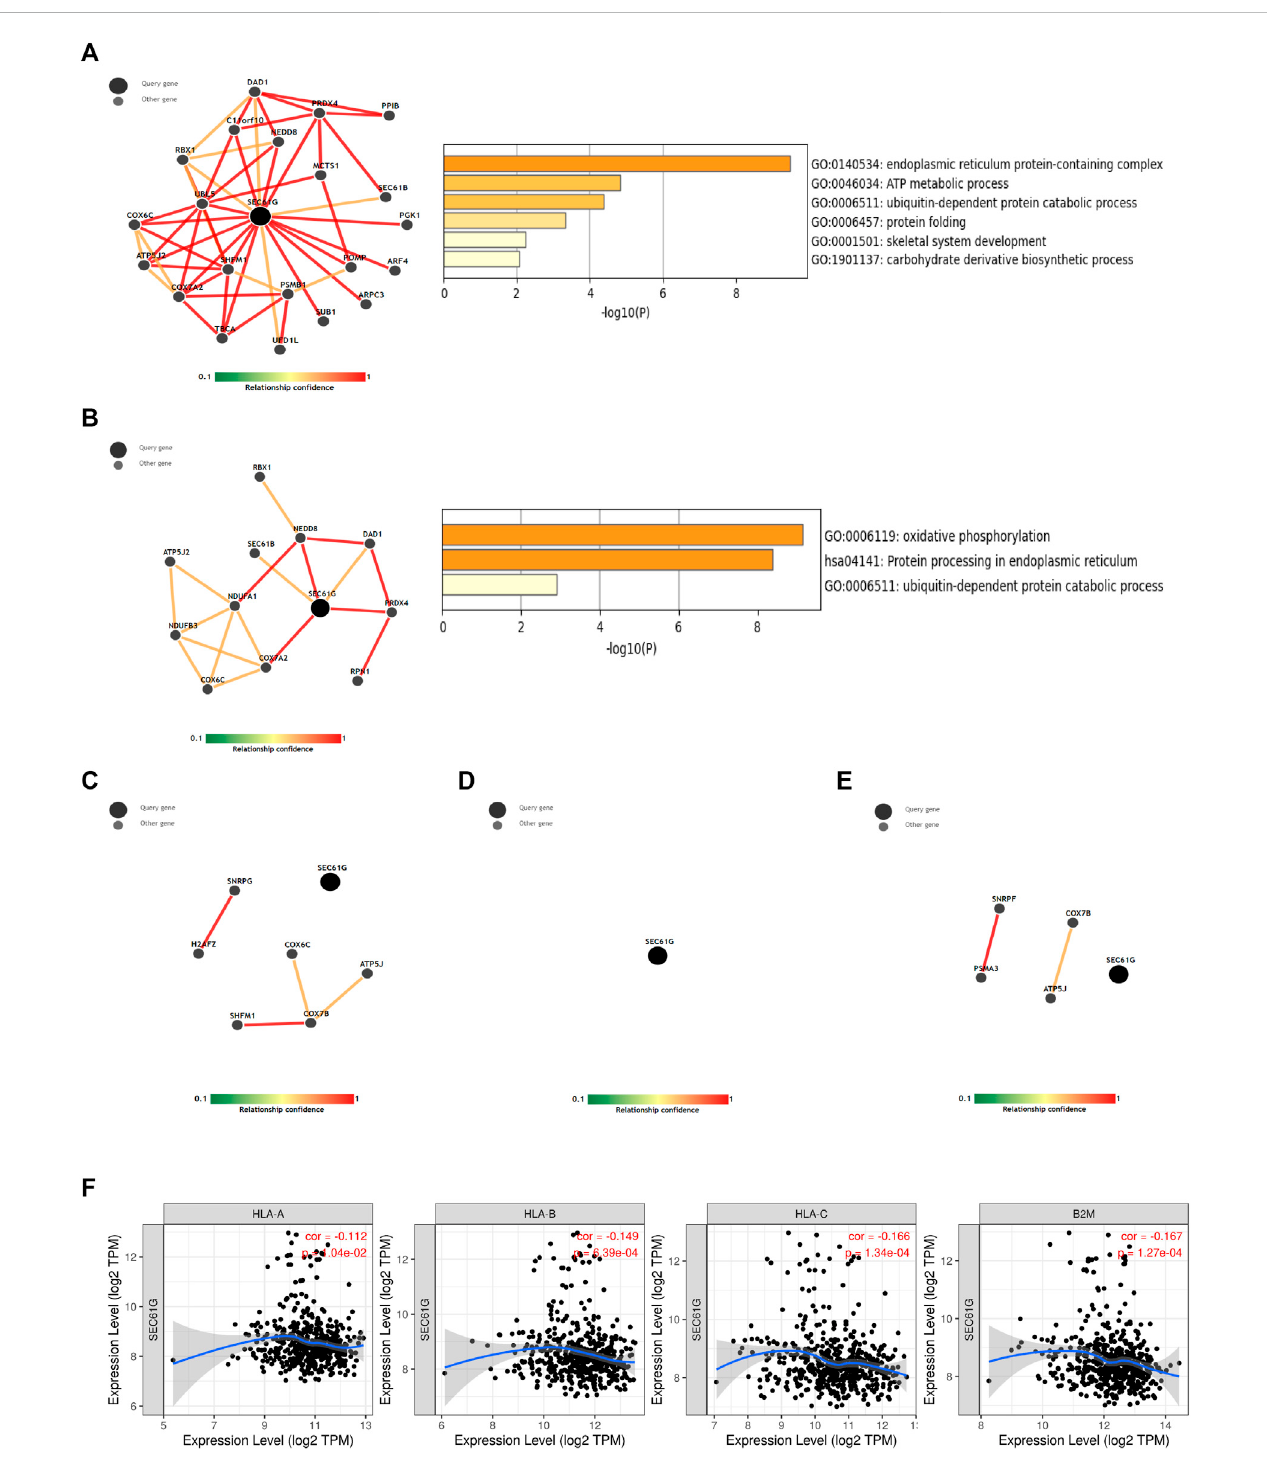
FIGURE 6 The immune-related analysis involving SEC61G. (A) A molecular network involving SEC61G in antigen processing and presentation based on ImmuNet analysis. (B) A molecular network involvingSEC61G innaturalkiller cellmediatedcytotoxicity basedonImmuNet analysis. (C) Nomolecularnetworkwasbuilt related to B cell receptor signaling pathway. (D) No molecular network was built related to T cell receptor signaling pathway. (E) No molecular network was builtrelatedtochemokinesignalingpathway. (F) ThecorrelationbetweenSEC61GexpressionandkeycomponentsinMHC-IpresentationinHNSCC via